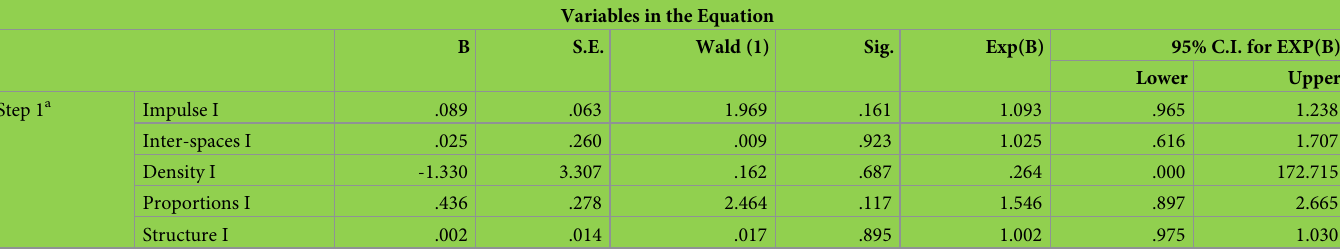
Table 8. Logistic regression model.